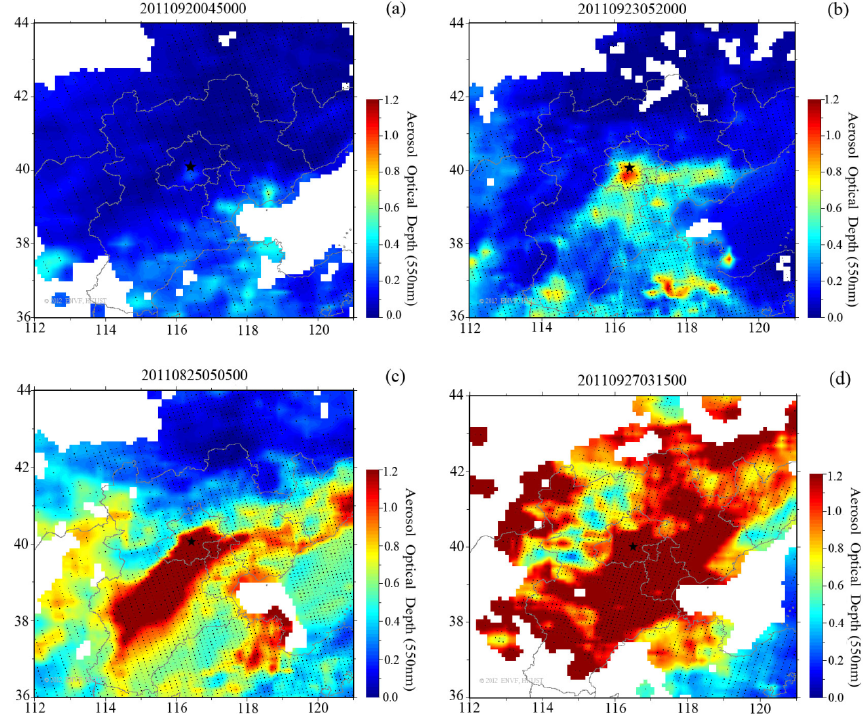
Fig. 8. Aerosol optical depth measured by MODIS on (a) 20 September, (b) 23 September, (c) 25 September, and (d) 27 September. Black star denotes measurement site.